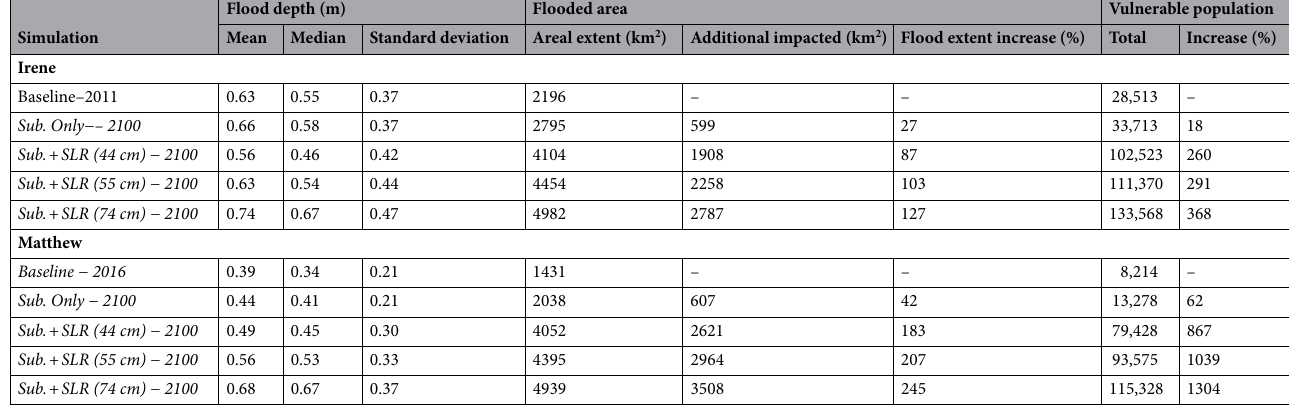
Table 2. ADCIRC simulation summary statistics for shown APES region. Areal overland extent determined as areas with positive water depths over the land surface as defined by the present-day DEM. Vulnerable population statistics derived from CIESIN 2017 datasets (2010 U.S. Census) 20